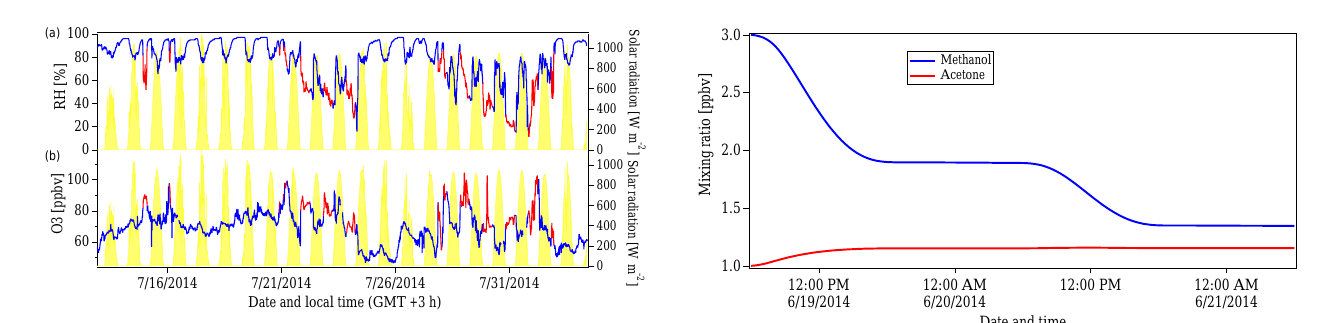
Figure 8. Modeled mixing ratios of methanol and acetone in ppbv over the period of 48h starting at 06:00. Initial values originate from the MOM chemistry in the global model EMAC (Jöckel et al.,